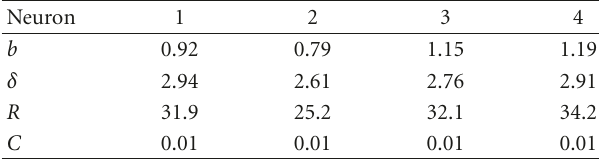
Table 1: Nominal values of the neuron parameters ( δ represents the mean value of the threshold